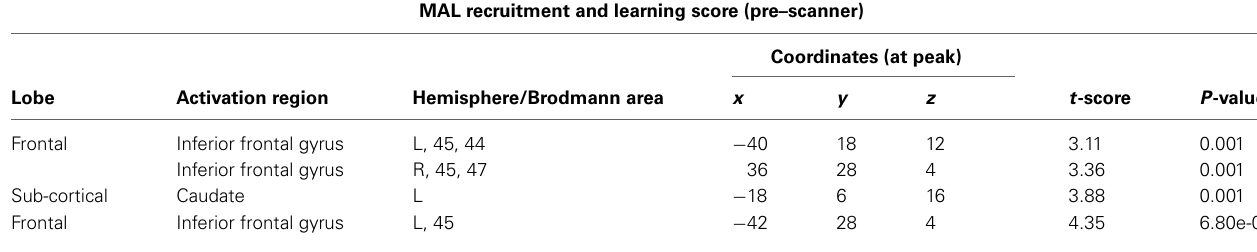
Table 7 | Group level whole brain regression with learning scores. MAL recruitment and learning score